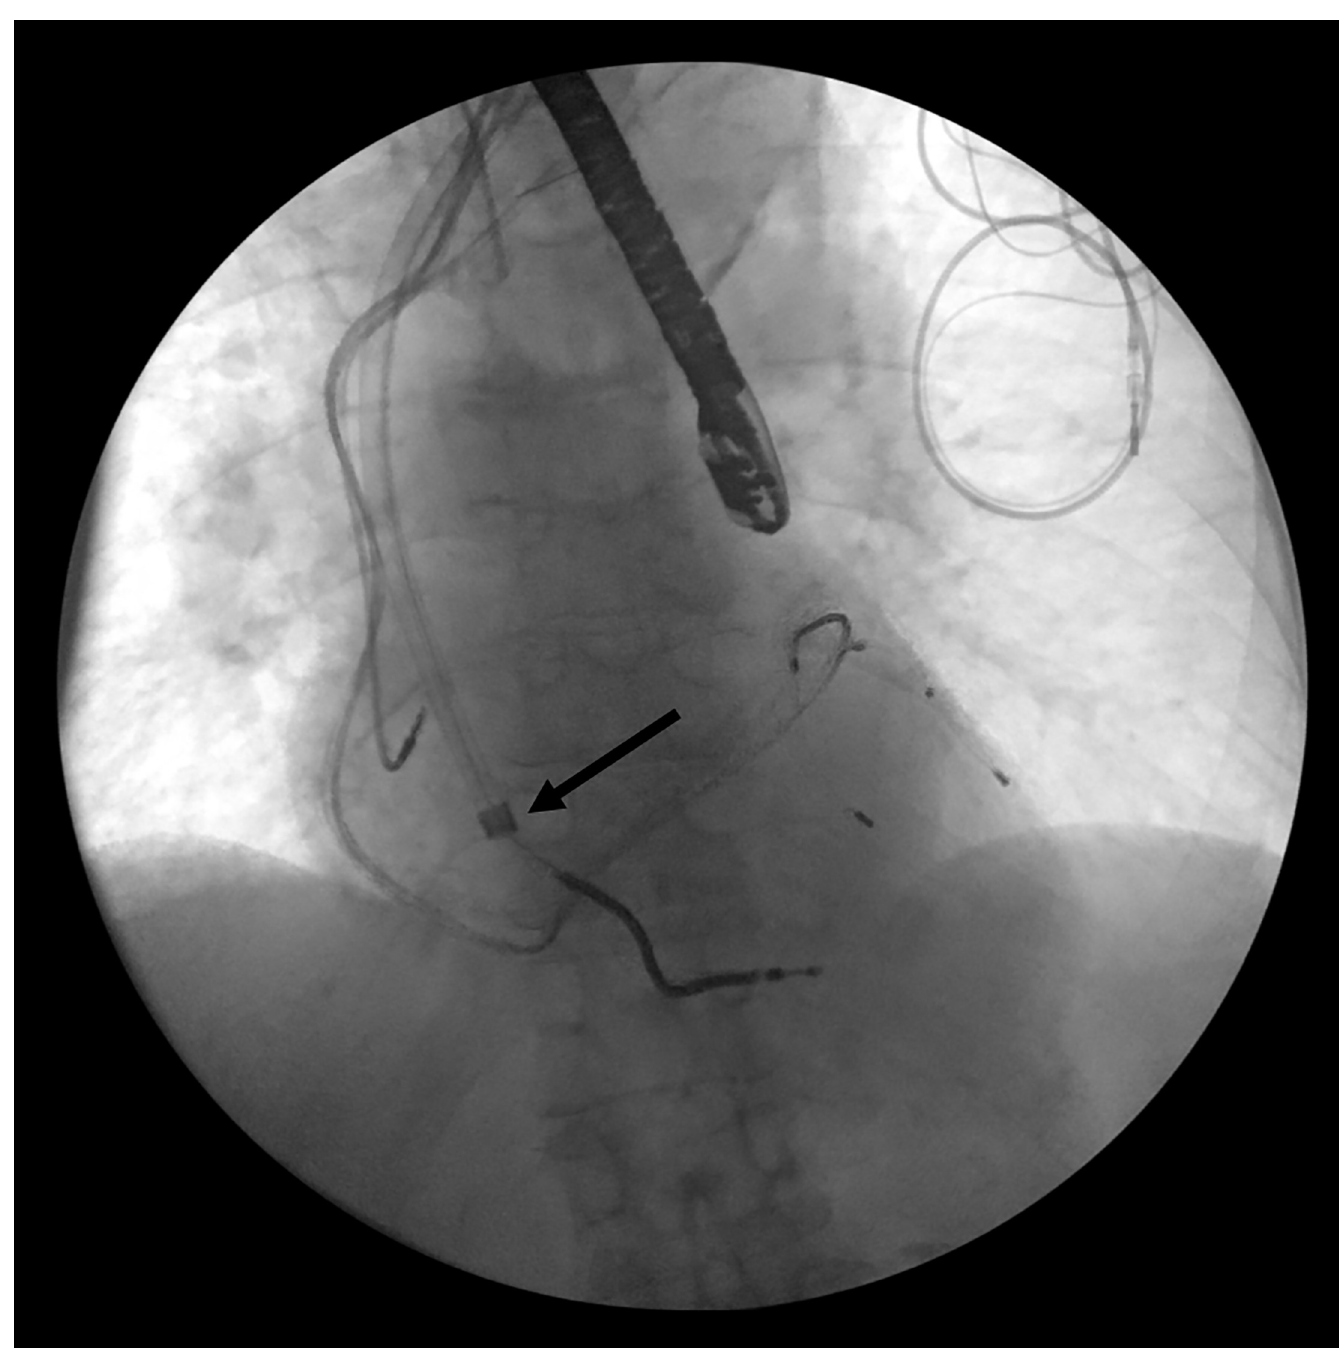
Fig 3. Further advancing of the laser sheath over the lead marked by the